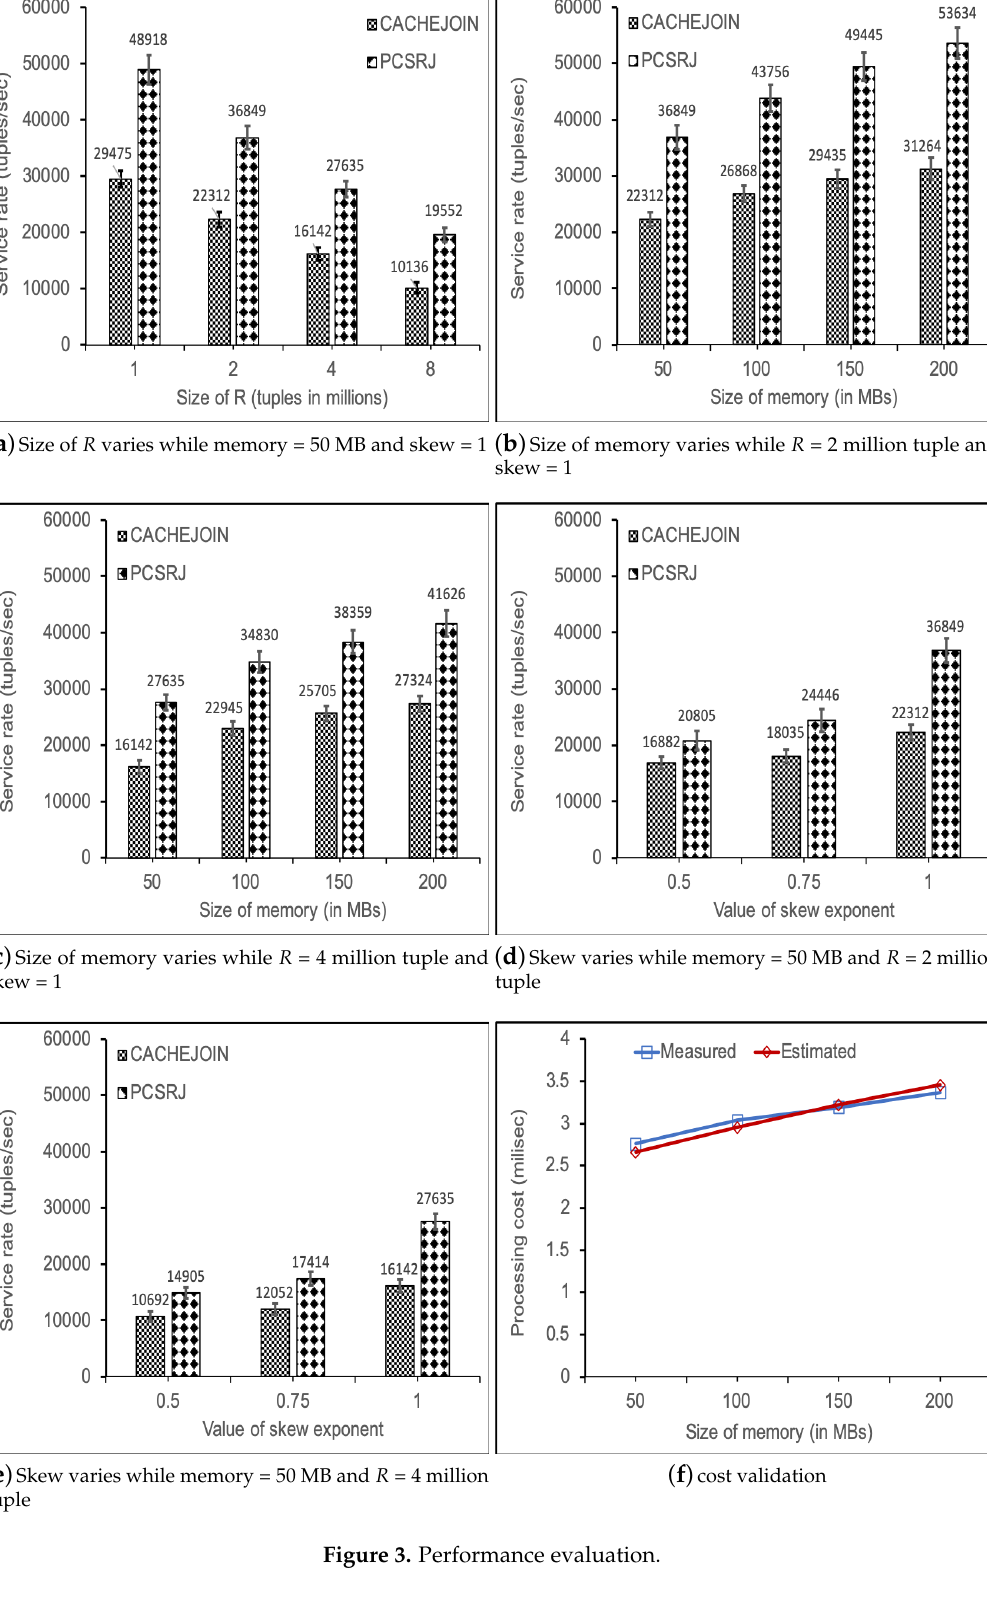
Figure 3. Performance